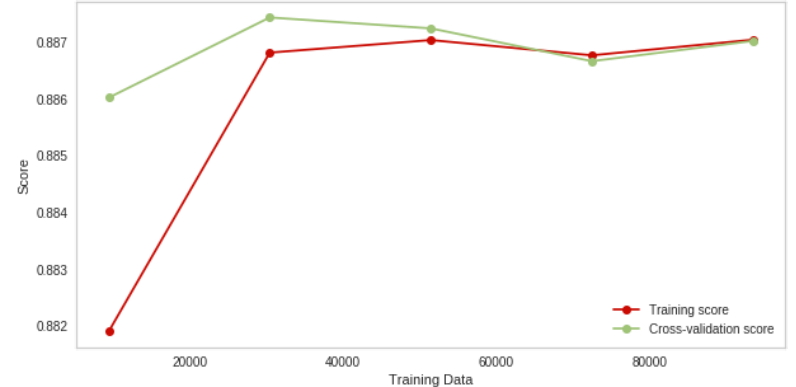
Figure 11. Logistic regression training learning